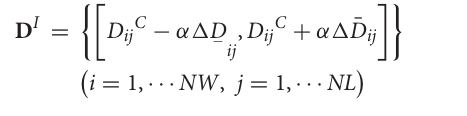
NS direction component and the EW direction component. Table 1B indicates the source parameters of the fault plane and sub-faults.